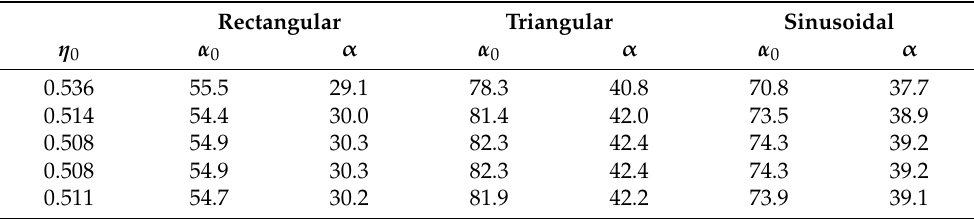
Table 4. Limit and mean orientation angles computed from the orientation factor for different packing